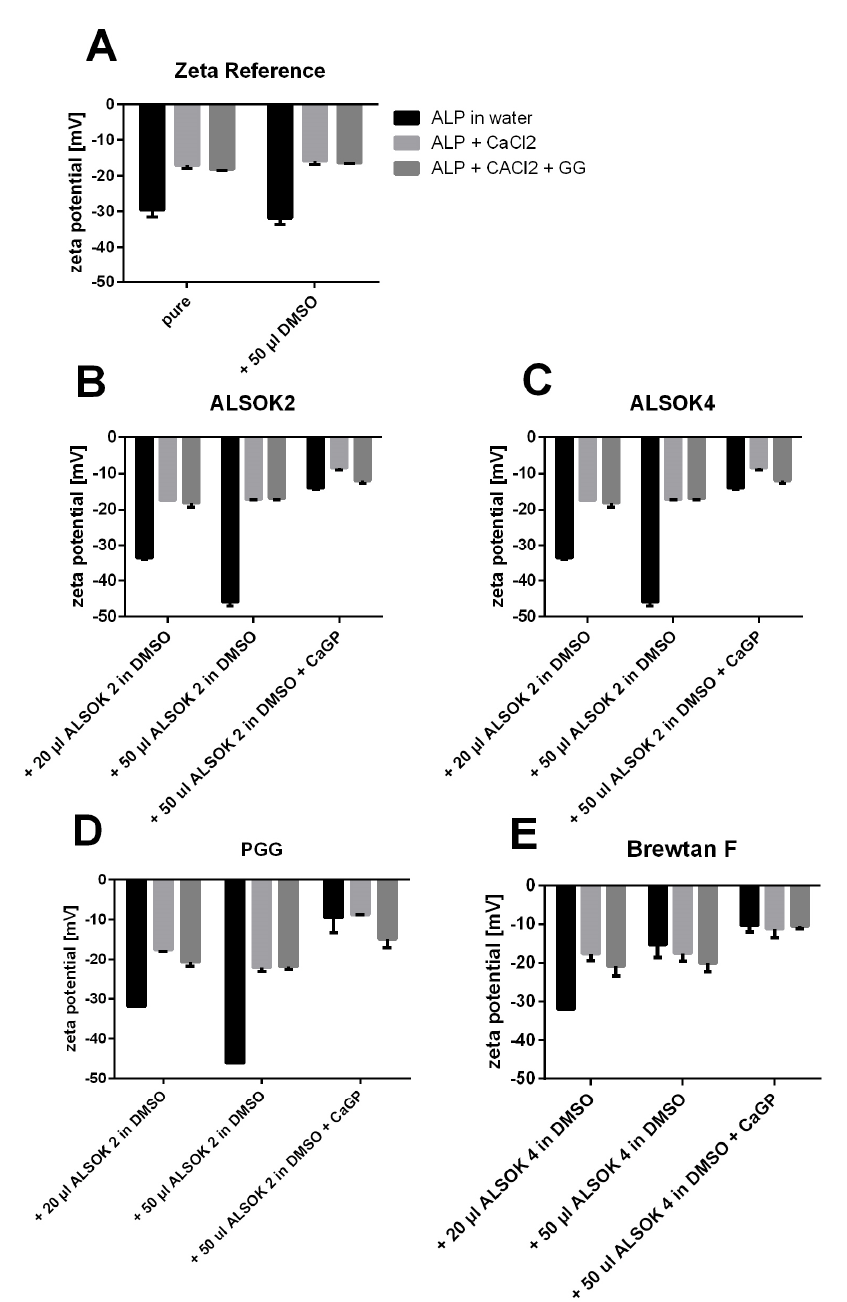
Figure 4. Zeta potential (mV) of ALP in water, ALP with CaCl 2 , and ALP with CaCl 2 and GG with 20 or 50 µ L of gallotannins in DMSO and with CaGP: ( A ) without gallotannins; ( B ) ALSOK2; ( C ) ALSOK4; ( D ) PGG; ( E ) Brewtan F. In all cases, n = 3.